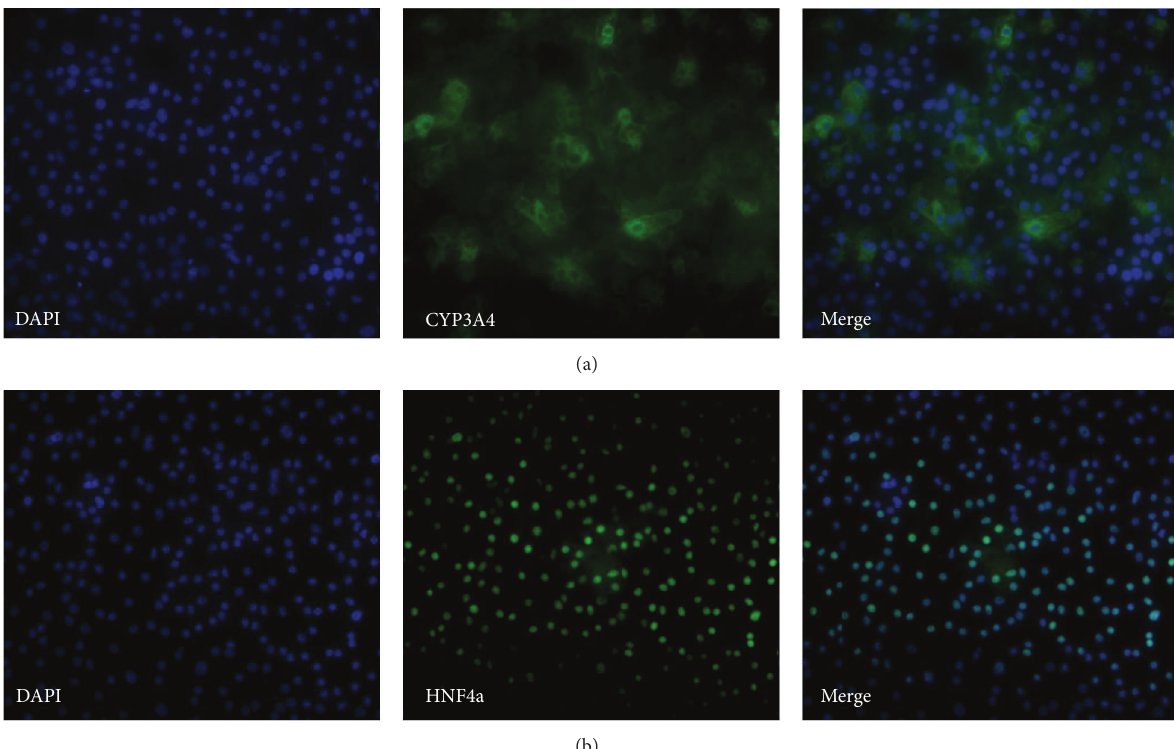
Figure 12: Representative micrographs illustrating the expression of markers at day 30. Panel (a) shows stainings for CYP3A4 (AS034, 20x magnification). Panel (b) shows stainings for HNF4a (AS034, 20x